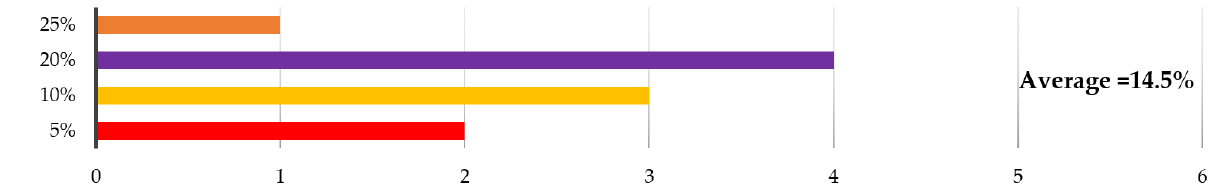
Figure 15. Responses to the question: “In your opinion, what should be the ideal percentage of BIM management/coordination hours of total hours of the lead-appointed party team? E.g., 1000 h of BIM coordination out of 5000 h of total team time = 20%” .